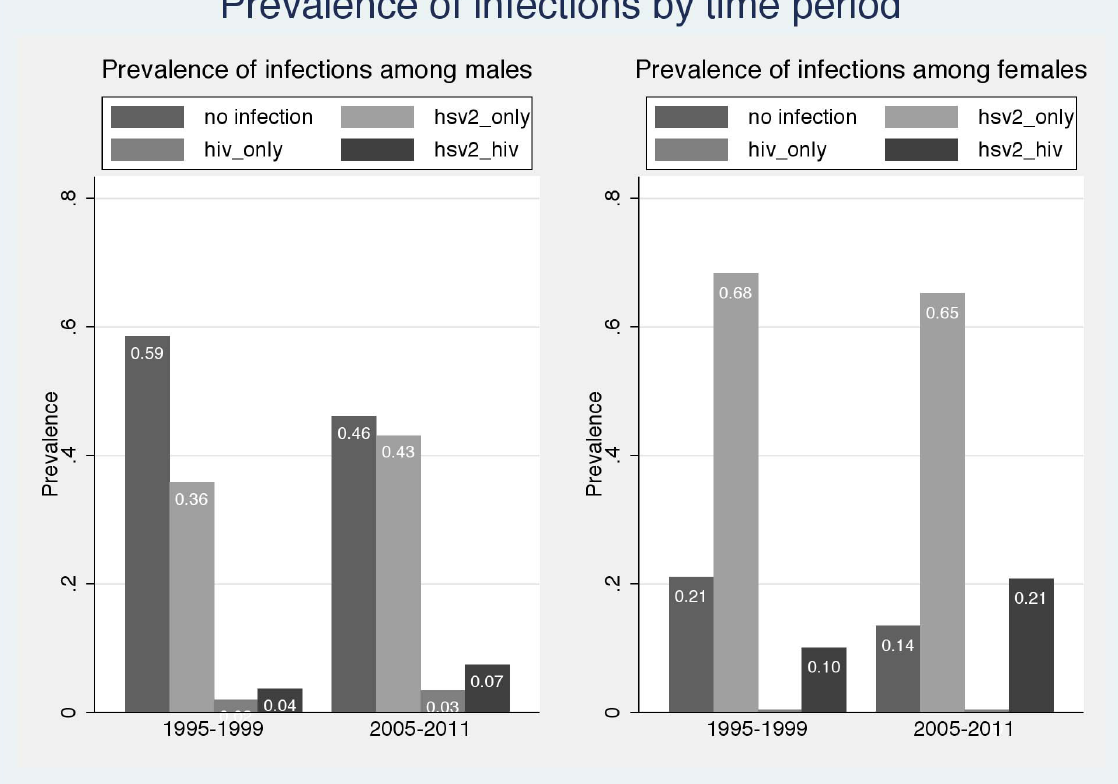
Figure 1. HSV-2 and HIV Infection among non-injecting drug users who participated in Beth Israel Medical Center treatment programs by time period: 1995–199 and 2005–2011.